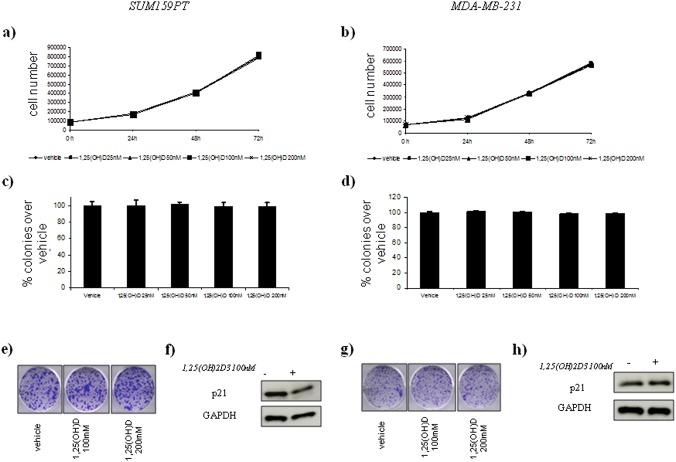
Vitamin D anticancer effects in vitro on ER(–) breast cell lines with AG Cdx2 status.Time-dependent growth curves of SUM159PT (a) and MDA-MB-231 (b) cells in the absence or in the presence of different doses of 1,25(OH)2D3 (25–200 nM). Histograms (c and d) showing average colony percentage over vehicle from duplicate experiments at 10–21 days from seeding. Bars indicate the average of three independent experiments. Representative micrographs of colonies formed by BT-20 (e) and HCC1954 (g) cells treated with 1,25(OH)2D3 as indicated. Representative western blot analysis of whole cell lysates obtained from SUM159PT (e) and MDA-MB-231 (f) cells treated as suggested and stained with the indicated antibodies. GAPDH staining was used as a loading control.